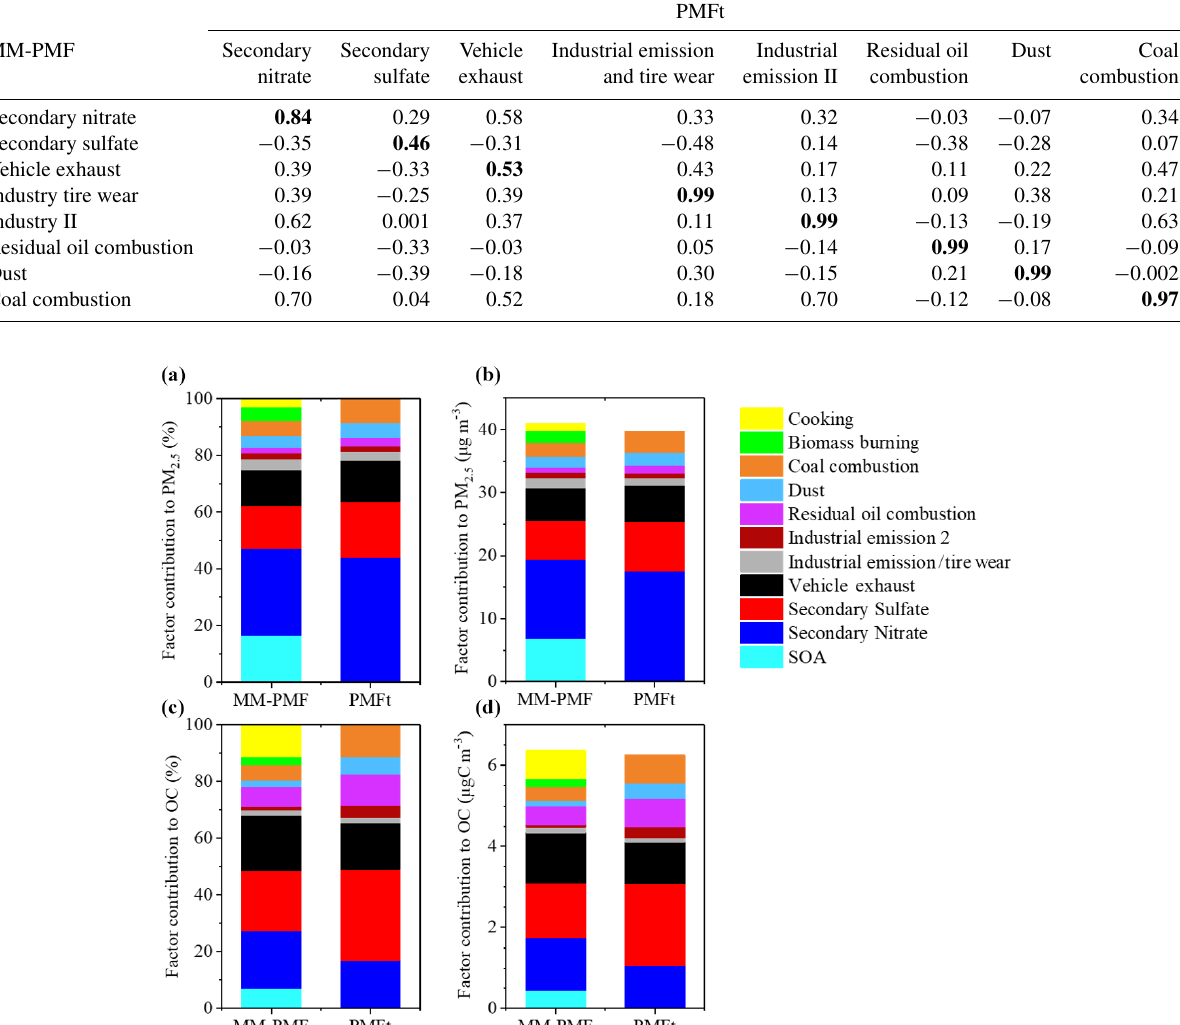
Figure 6. Comparison of individual factor contributions to PM 2 . 5 (a, b) and to OC (c, d) between MM-PMF and PMF t : (b, d) average mass contributions (µgm − 3 ) and (a, c) average percentage contributions